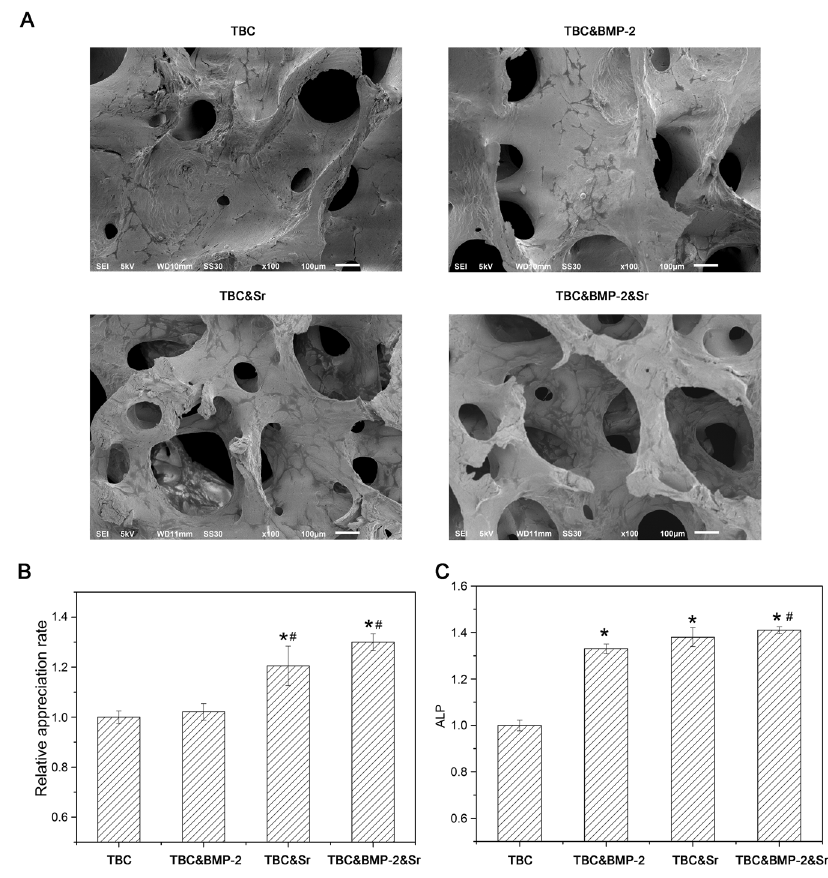
Fig. 1 A The surface topography of the bone material observed by scanning electron microscopy (SEM) (100×); B Effects of four materials on the MC3T3-E1 proliferation ( n = 4); C Effects of four materials on the ALP activity ( n = 4); compared with TBC, * p < 0.05; compared